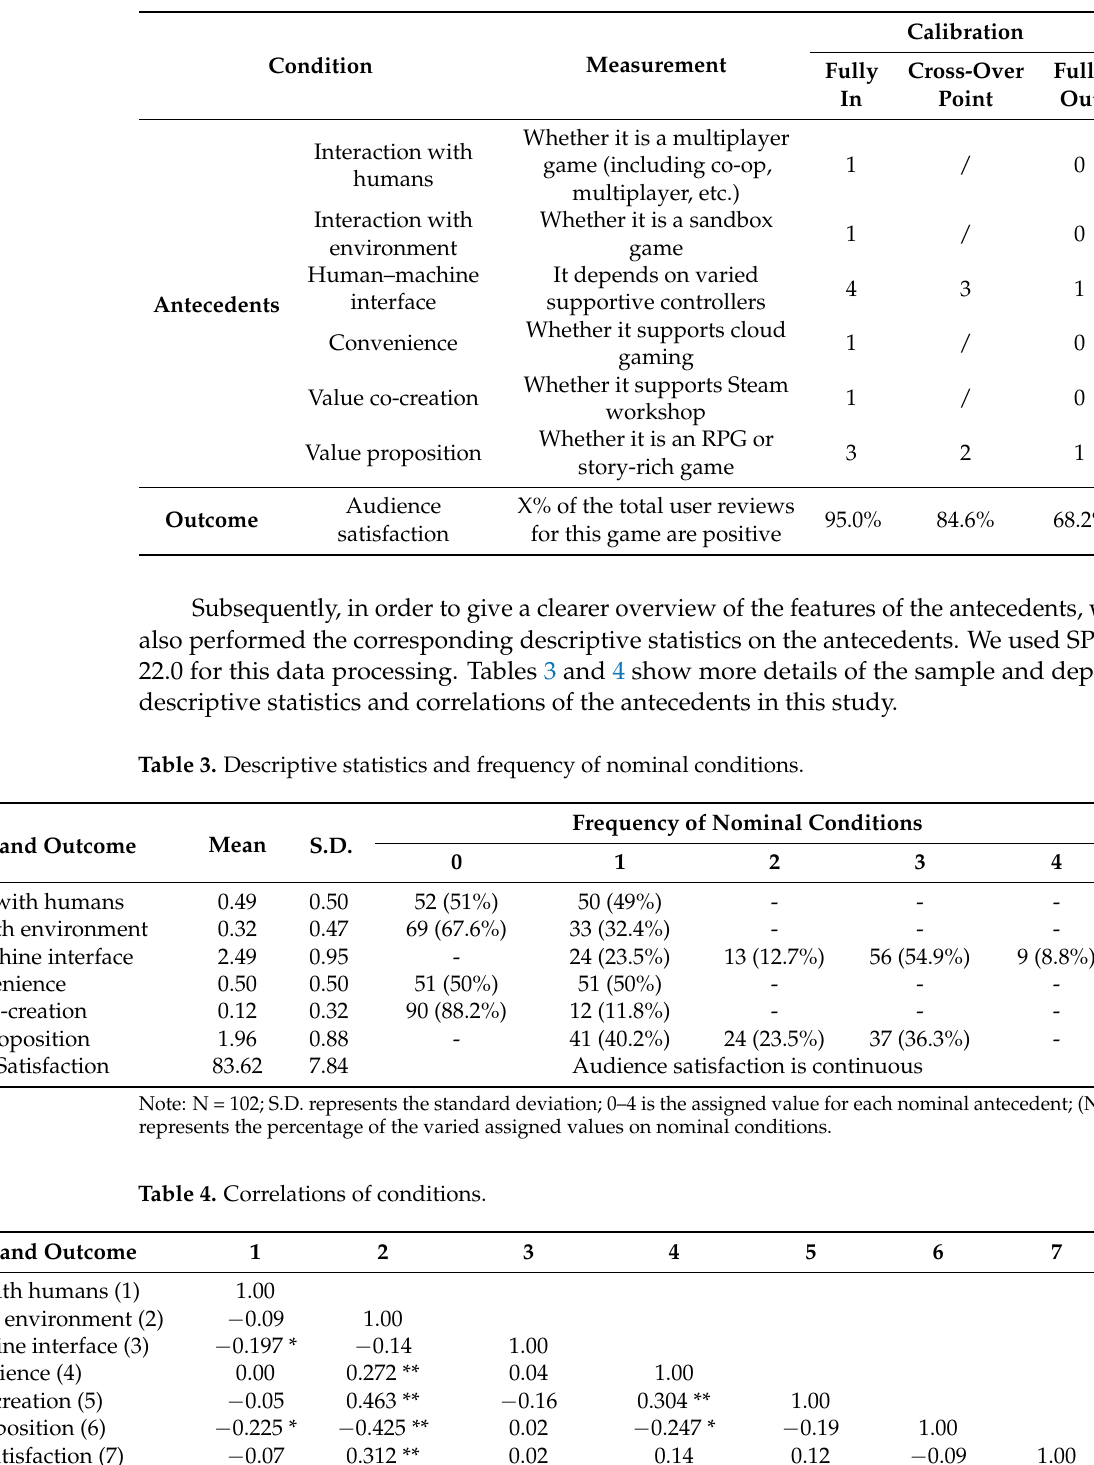
Table 2. Antecedent measurement and calibration. Condition Measurement Interaction with humans